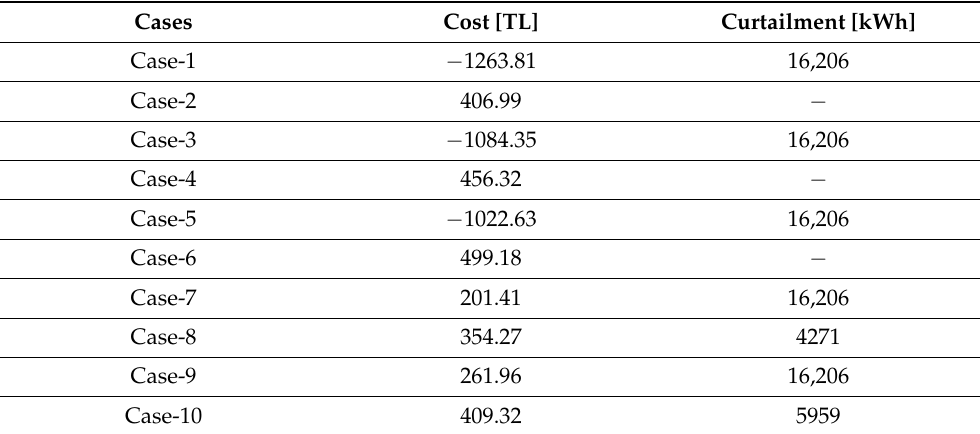
Table 6. Results for case studies.